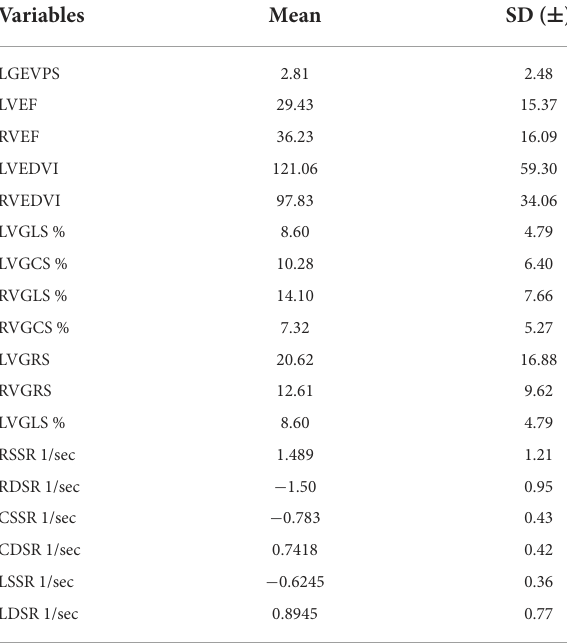
TABLE 4 mean and SD of CMR parameters in nine myocarditis patients who underwent endomyocardial biopsy. Variables Mean